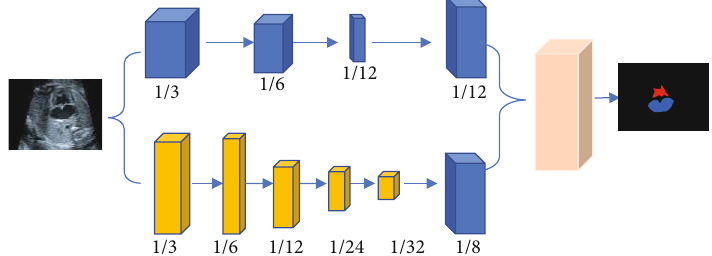
Figure 1: Double network echocardiography segmentation